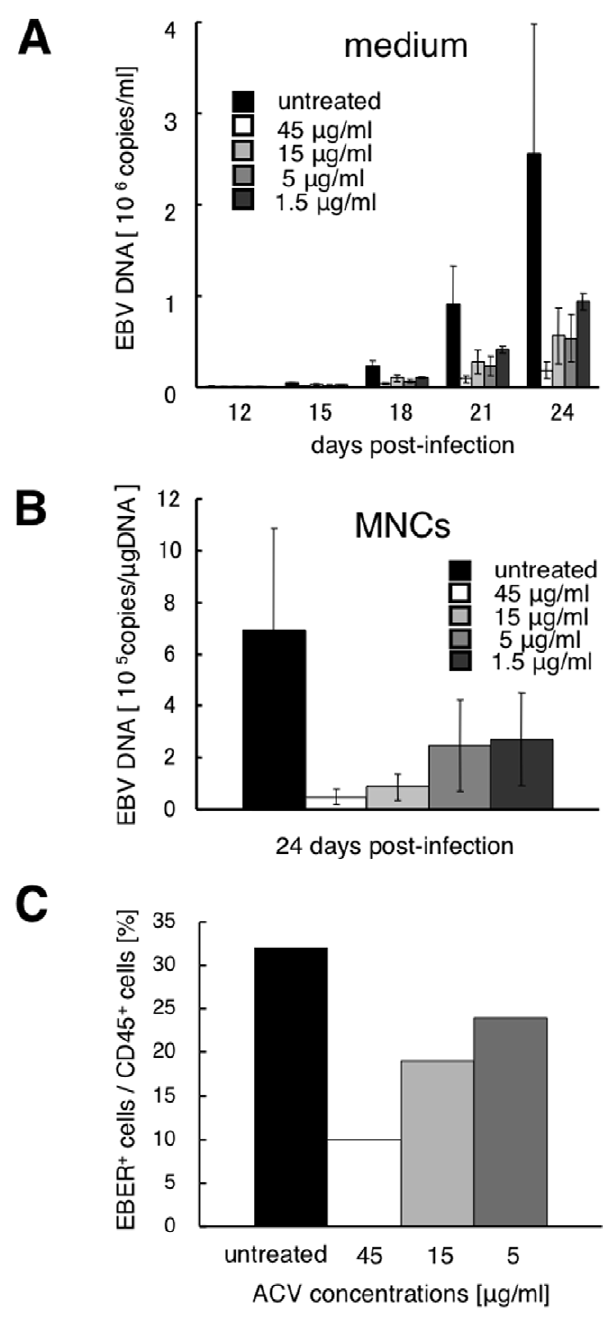
Figure 6. Inhibition by acyclovir (ACV) of EBV replication in human tonsillar tissues explants. Human tonsillar tissues were infected with B95–8 and treated with ACV at various concentrations. Antiviral activity of ACV was evaluated by comparing viral replication in ACV-treated tissues with that in untreated donor-matched control tissues. Data are presented as means 6 standard errors of mean. A ) Kinetics of EBV replication were measured by real-time PCR assay for viral DNA in culture medium ( n =3). B ) EBV DNA was quantified in cells at 24 days post-infection ( n =3). C ) Comparison of the number of EBV- infected cells in the presence or absence of ACV at 24 days post- infection using FISH assay ( n =1).